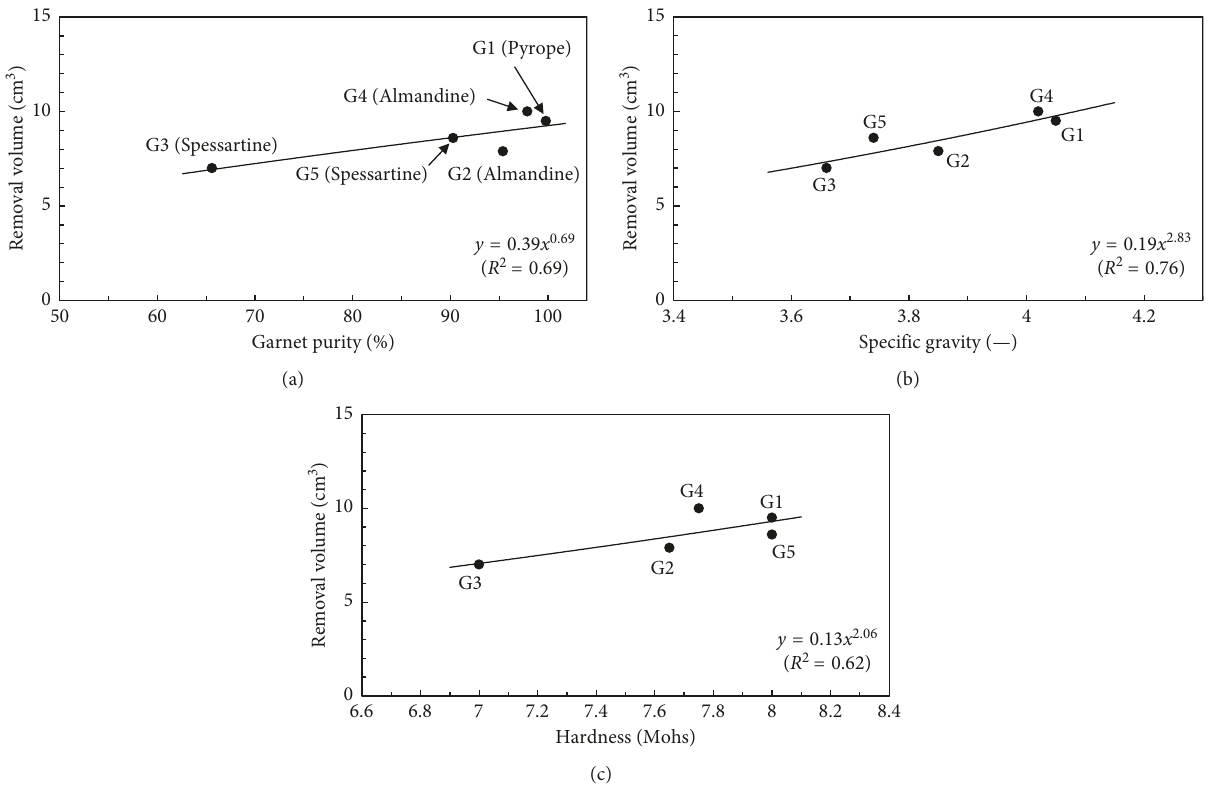
Figure 8: Relationship between removal volume and (a) garnet purity, (b) specific gravity, and (c) hardness at a uniform particle size of